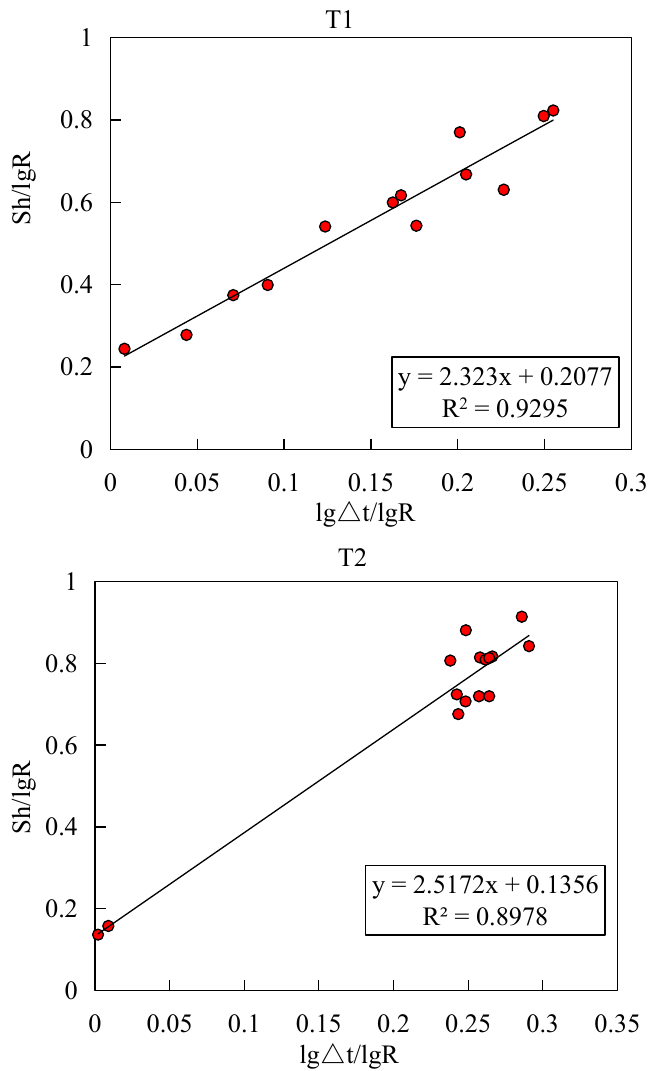
Figure 9. Coefficient fitting diagram of resistivity–acoustic time difference formula.